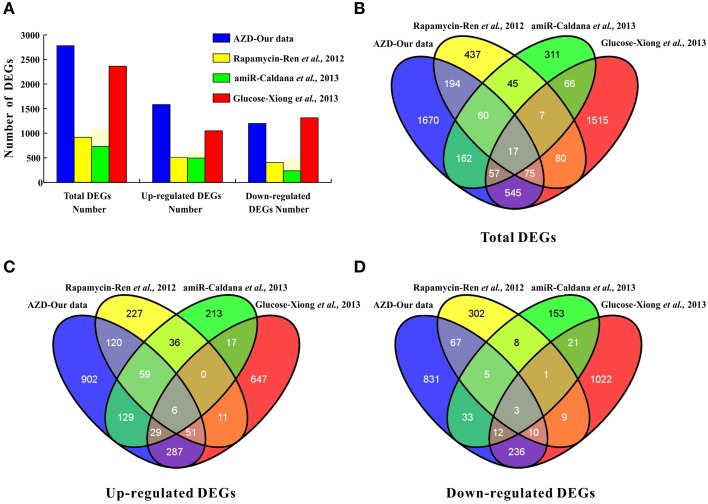
Comparisons to other studies, i.e., (Ren et al., 2012; Caldana et al., 2013; Xiong et al., 2013). (A) The number of DEGs. (B) The number of total DEGs shared among the four studies is represented by overlapping circles. (C) The number of up-regulated genes shared among the four studies is represented by overlapping circles. (D) The number of down-regulated genes shared among the four studies is represented by overlapping circles.